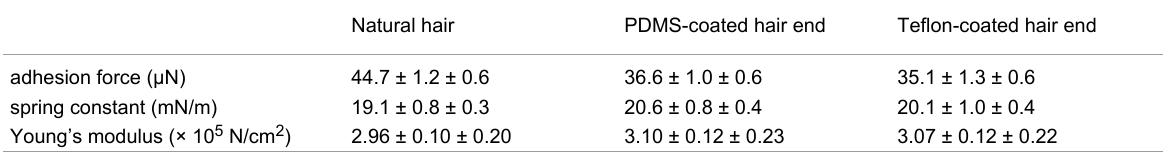
Table 1: The elastic and adhesive behavior of human head hairs with different coatings.